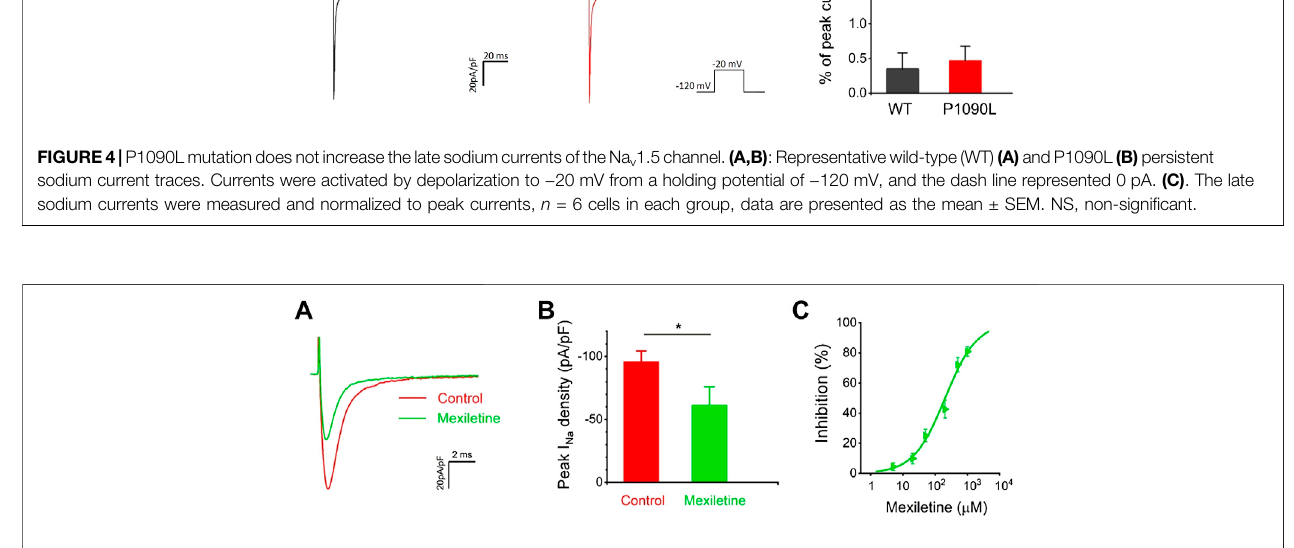
Frontiers in Physiology |